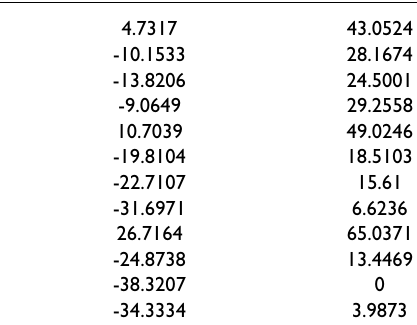
Table 2: A log linear model analysis testing for the relationship between mtDNA genetic background (haplogroup J1 versus all other haplogroups in the aggregate), T2DM status of the parents (I), T2DM status of the siblings (S) and population-of-origin (P). Model